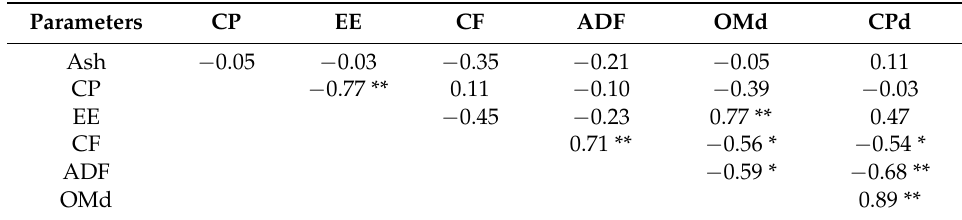
Table 2. Correlation coefficients between chemical components of insect meals and in vitro digestibility of organic matter (OMd) and crude protein (CPd).